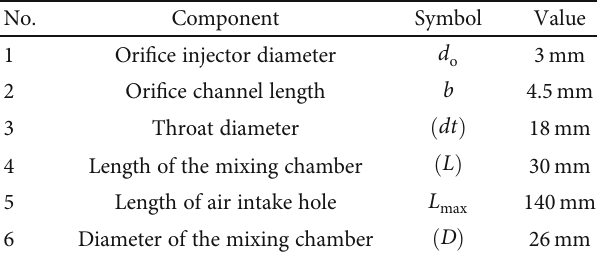
Table 7: Dimension of the burner major